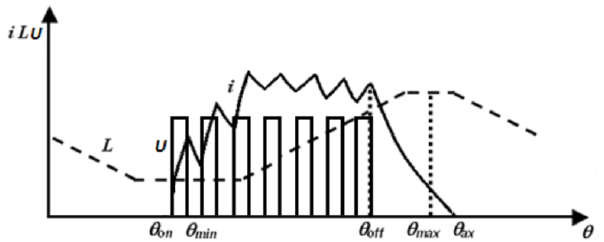
Figure 11. Voltage control. The waveform of current i , voltage U ( PWM ), and Phase inductance L of the SRM motor as a function of the position of the angle of the rotor poles in relation to the stator poles ϕ